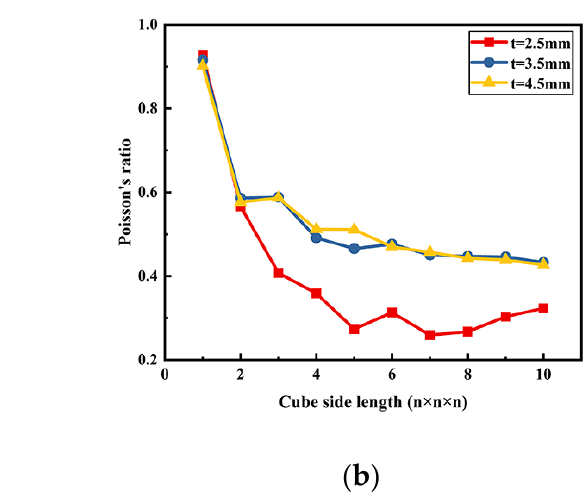
Figure 6. Mechanical properties of the rigid lattice. ( a ) The relationship between the elastic modulus and the cube side length of the rigid lattice (t = 2.5–4.5 mm); ( b ) The relationship between the Poisson’s ratio the cube side length of the rigid lattice (t = 2.5–4.5 mm).